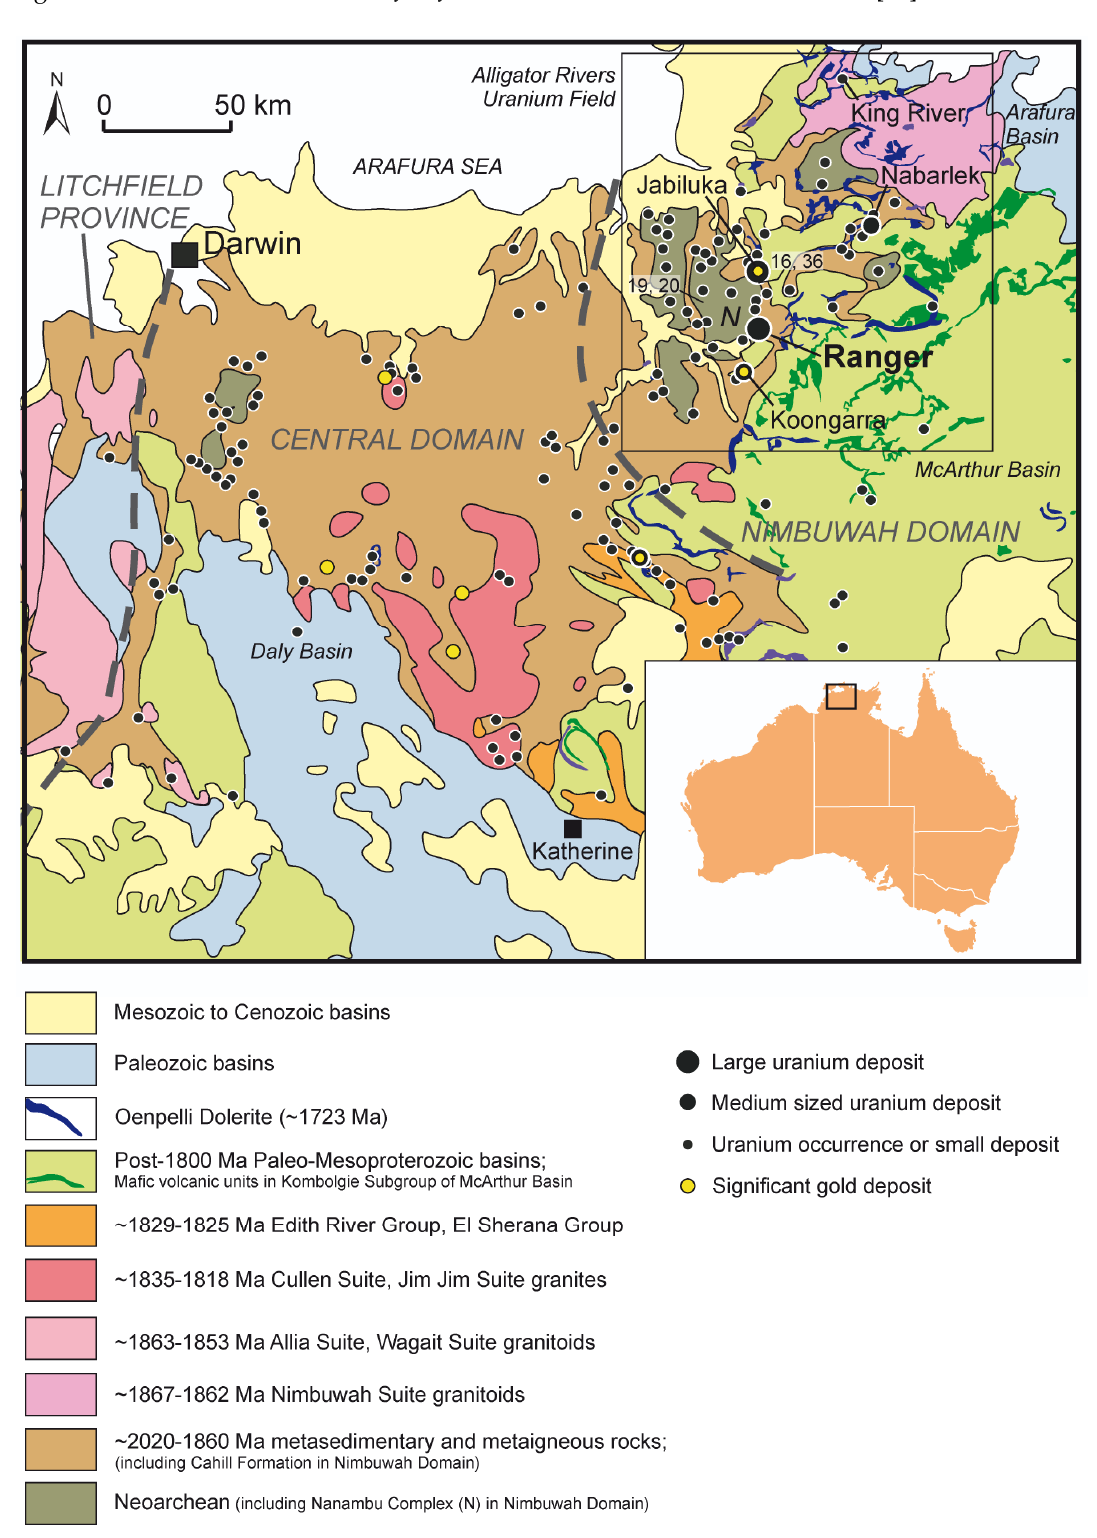
Figure 1. Location and geology of the Pine Creek Orogen comprising the Nimuwah, Central and Litchfield Domains, and the location of the Ranger deposit and other uranium and gold deposits and occurrences within the Alligator Rivers Uranium Field (labelled box). After Skirrow et al. [4].